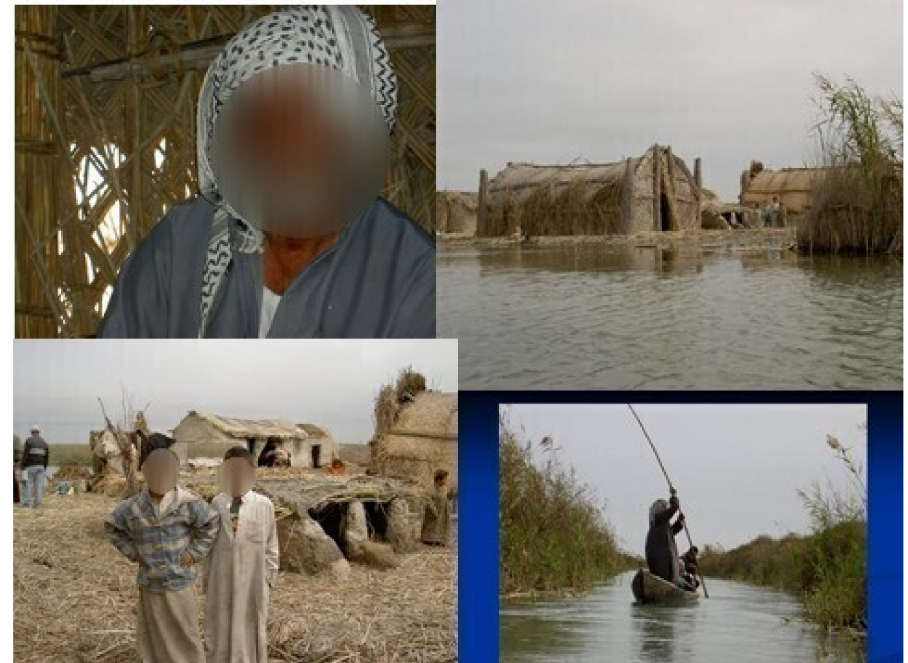
Figure 6. Present-day Marsh Arabs (Madan) in Southern Iraq (former Mesopotamia) with traditional reed houses (mudhif) often on floating islands and long canoe (mashuf) in a channel through marshland reflooded after 2003. Source: Edward